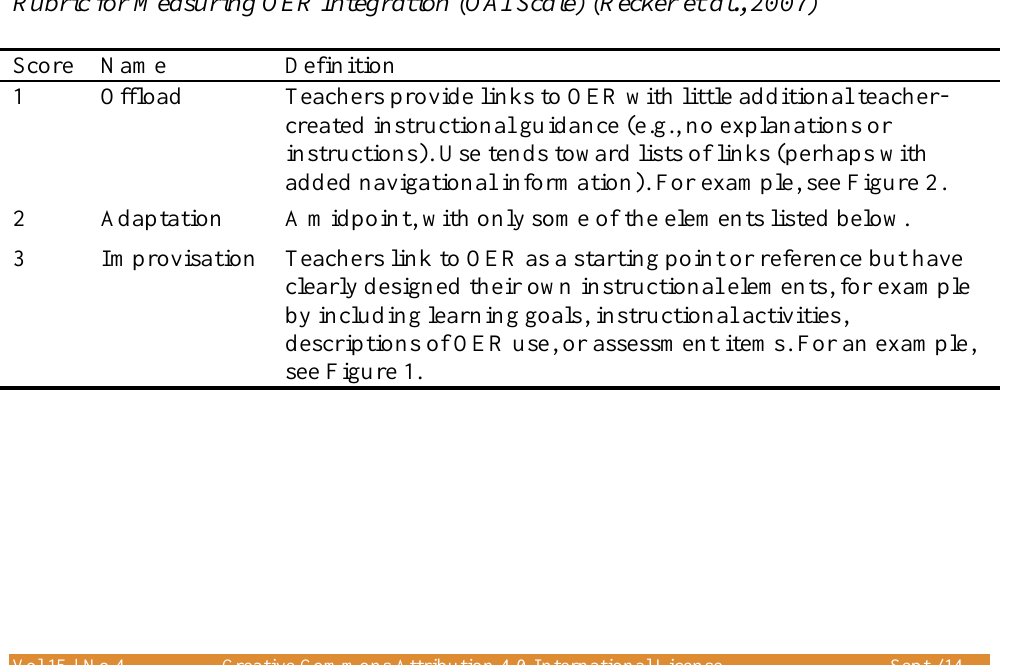
Rubric for Measuring OER Integration (OAI Scale) (Recker et al.,